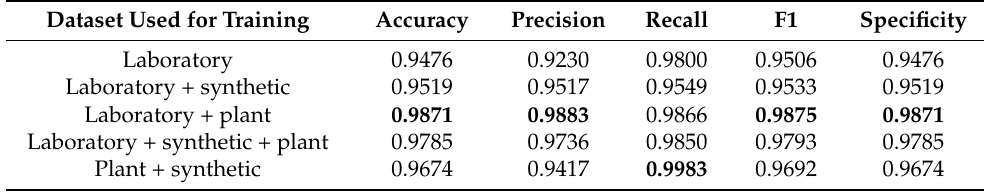
Table 5. Results of the Dimmer CNN.